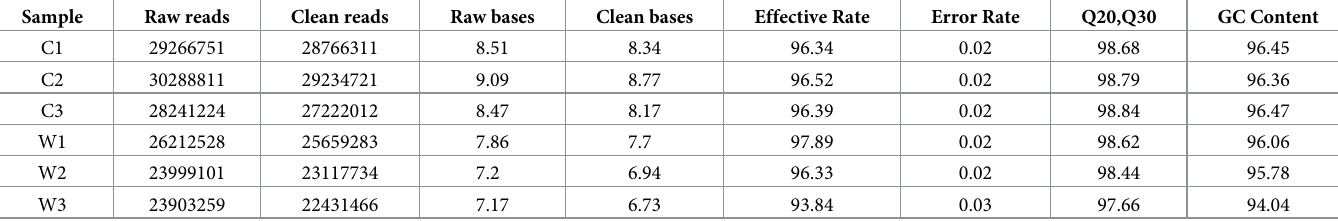
Table 1. Statistical table of sequencing data quantity and